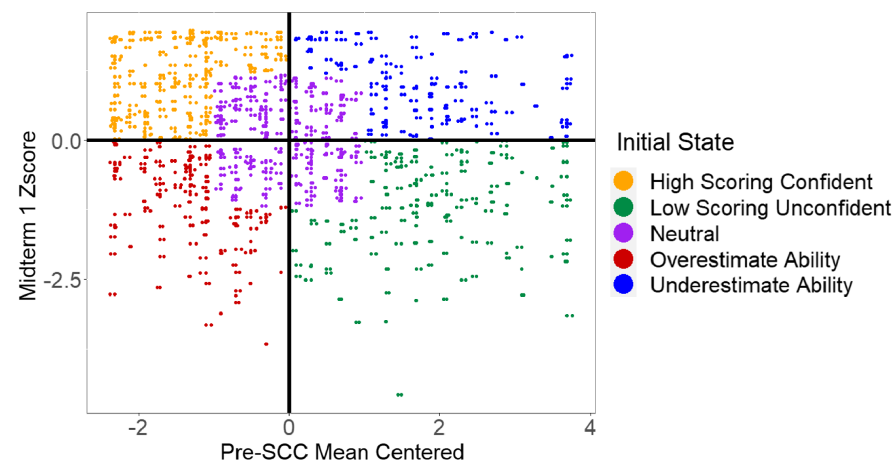
FIG. 3. The five initial-state groups as determined in SCC-midterm 1 score space. Each point represents a